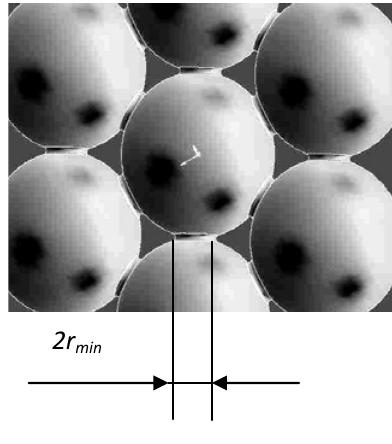
Figure 2. Porous structure